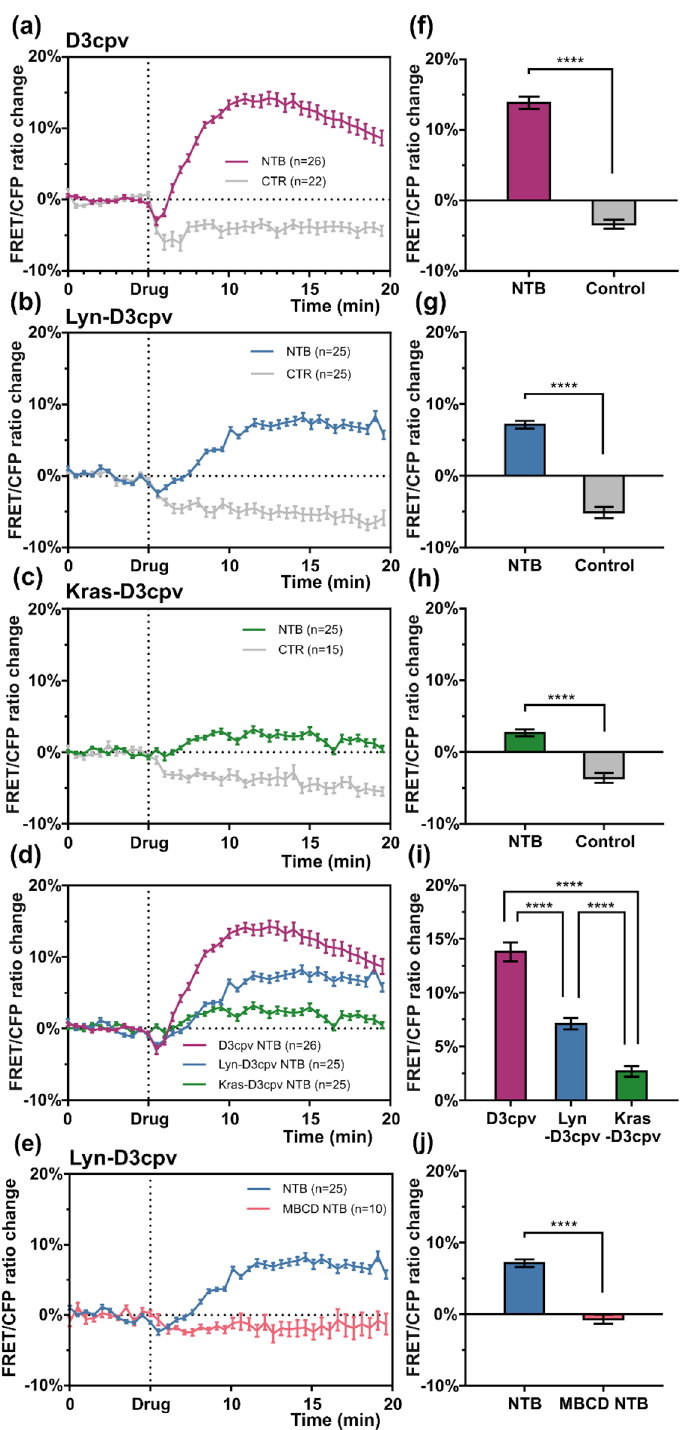
Figure 2. Graphs of the fluorescence resonance energy transfer (FRET)/enhanced cyan fluorescent protein (CFP) ratio change showing the difference in transient receptor potential subfamily M member 7 activity at distinct microdomains of a cell PM. The results were obtained from the following biosensors: ( a ) D3cpv, ( b ) Lyn-D3cpv, and ( c ) Kras-D3cpv. ( d ) The superposition of line graphs from ( a ), ( b ), and ( c ). ( e ) The FRET/CFP ratio change of Lyn-D3cpv from cells pretreated with methyl-beta-cyclodextrin compared to those that were untreated. Bar plots with the values of the FRET/CFP ratio change 12 min after the start of experiment ( f ) for the data from ( a ), ( g ) from ( b ), ( h ) from ( c ), and ( j ) from ( e ). Student’s t test, **** P < 0.0001. ( i ) Bar plots with the values from ( d ) 12 min after the start of the experiment. One-way analysis of variance, **** P < 0.0001. NTB, naltriben; n, number of the cells; CTR, control (dimethyl sulfoxide). Error bars in the line plots represent the standard error of the mean ( P <